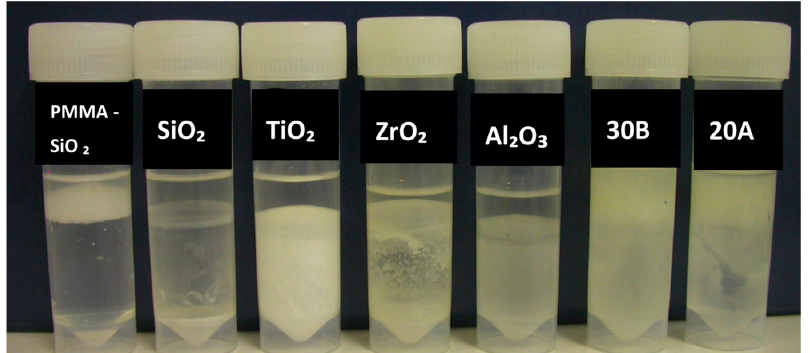
Figure 7. Particles stored for 24 h after mixing with monomer, prior to silane treatment, from left to right; impregnated PMMA by silica, silane treated silica, untreated TiO 2 , ZrO 2 , Al 2 O 3 and nanoclays 30B and 20A.